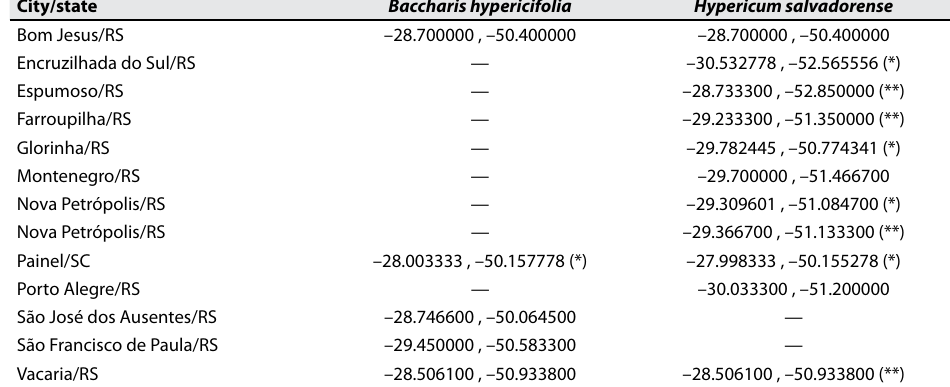
Table 1. Known records of Baccharis hypericifolia and Hypericum salvadorense in Rio Grande do Sul (RS) and Santa Catarina (SC), Brazil.